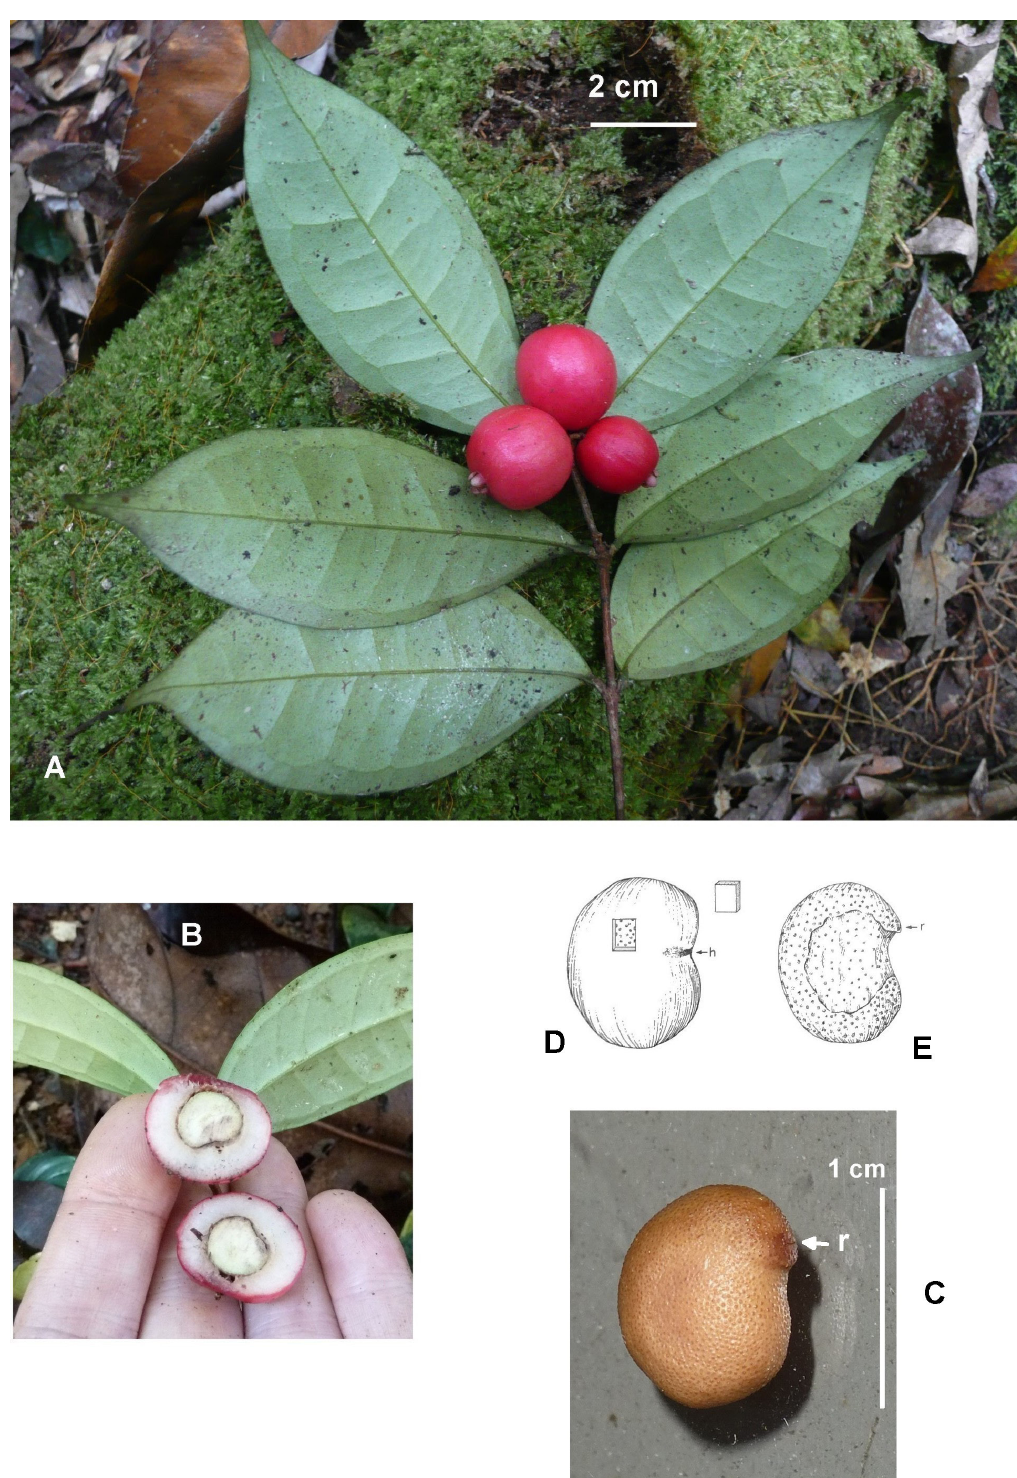
Fig. 2. A–C. Eugenia sapoensis sp. nov. A . Branchlet with fruit. B . Cross section of the fruit and single large seed. C. Lateral view of embryo (r = radicular protuberance). D – E . Morphology of the seed of Eugenia “Group X” as described by van Wyk (1980). D . Seed with part of the thin testa removed showing the surface of the embryo beneath (h = hilum). E . Lateral view of embryo (r = radicular protuberance). A–C from Jongkind 9351 ; D & E from van Wyk & Botha (1984: 66). Photographed by the